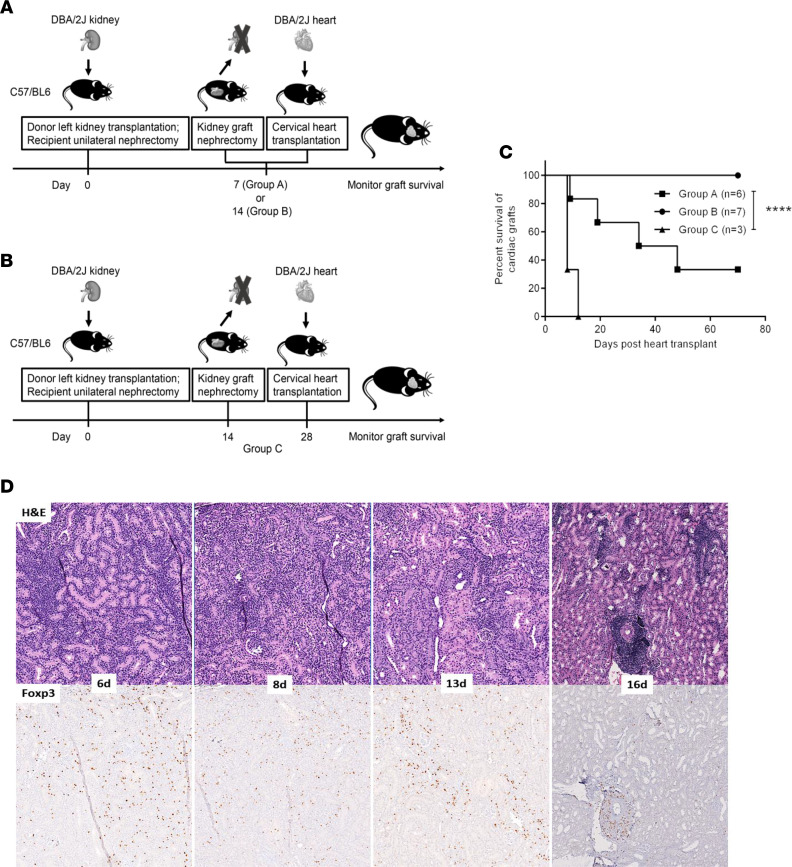
Effect of kidney graftectomy on cardiac graft survival.(A and B) Schematic representation of experimental design in assessing the influence of kidney graftectomy on cardiac graft survival. DBA/2 kidneys were first transplanted into unilaterally nephrectomized B6 recipients; 7 (group A) or 14 (group B) days later, kidney allografts were removed and recipients received cervical DBA/2 heart transplants. Survival of cardiac grafts was monitored by assessing the cardiac impulse. (B) To determine if systemic tolerance is maintained long term after the removal of the kidney allograft, transplantation of heart allografts was delayed 14 days after kidney transplants were removed. Survival of cardiac grafts was similarly monitored by assessing palpations (group C). (C) Survival curves of cardiac allografts in each experimental group described in A and B (group A, kidney allograft removed 7 days after transplant, n = 6; group B, kidney allograft removed 14 days after transplant, n = 7; group C, kidney allograft removed 14 days after transplant, and heart allograft transplanted 14 days after that, n = 3). Graft survival curves were constructed by the Kaplan-Meier method. ****P < 0.0001, log-rank test. (D) H&E and Foxp3 staining of DBA/2 kidney allografts isolated on day 6, 8, 13, and 16 after transplantation. TOLS formation is observed within the kidney allograft between 13 and 16 days. Original magnification, ×400.